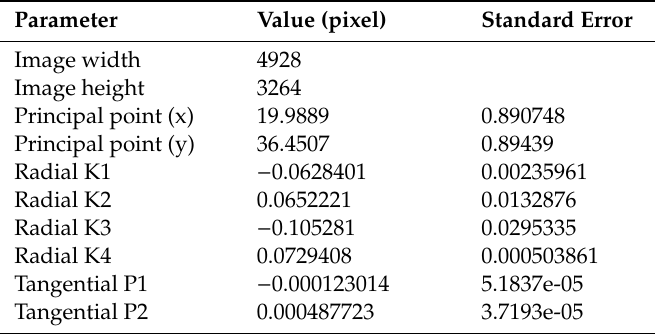
Table 1. Camera calibration